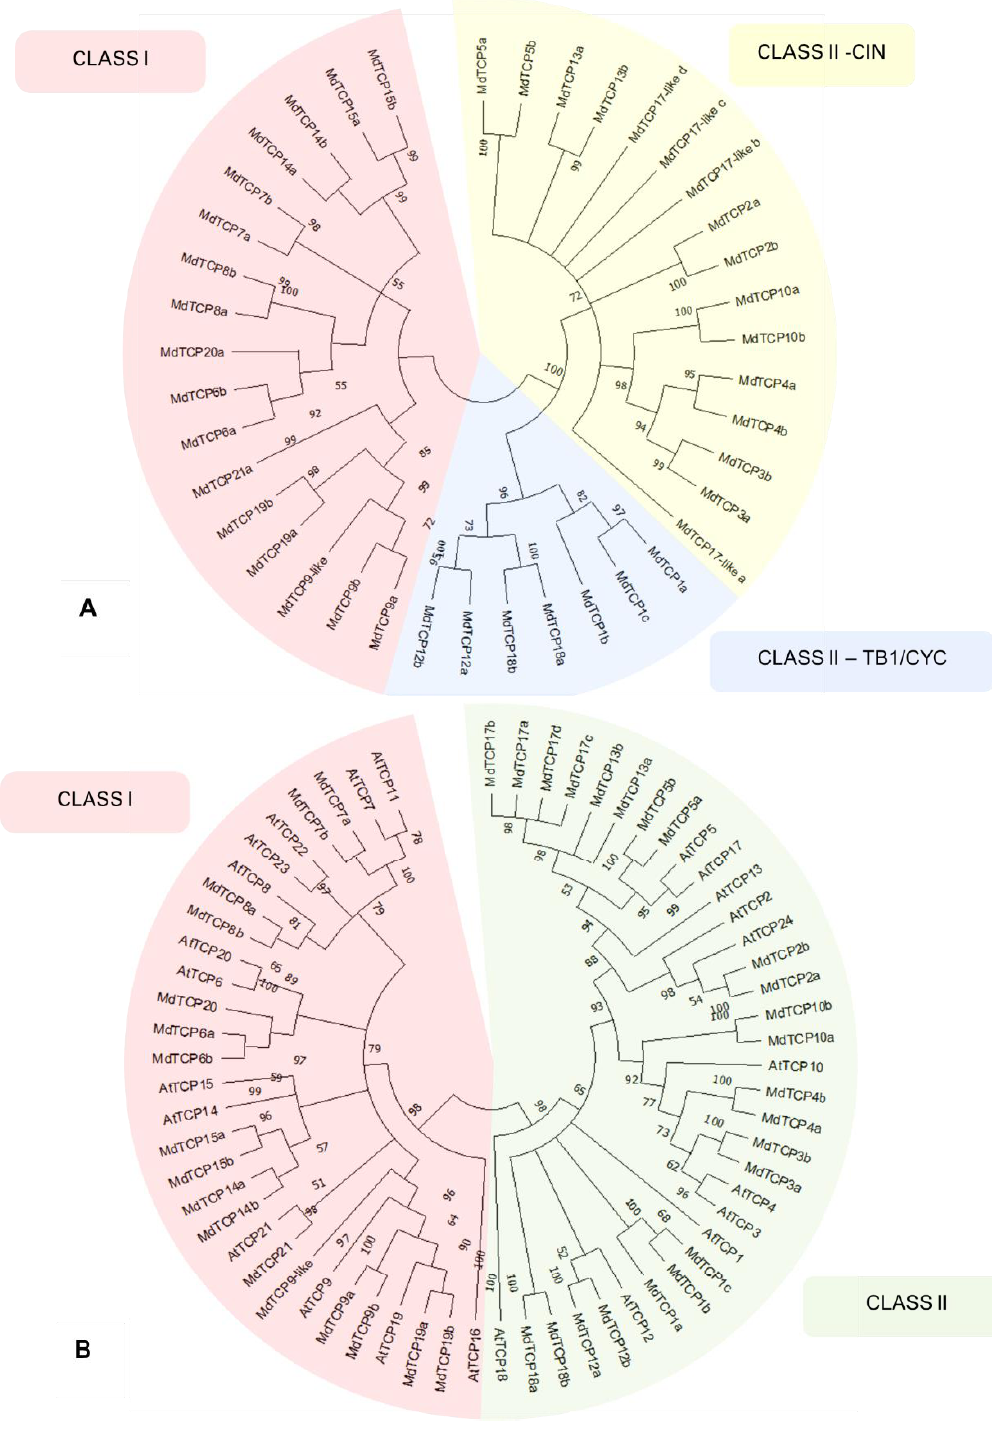
Figure 4. ( A ) Phylogenetic tree calculated on the 40 MdTCP genes classified in the present work. The different classes of TCPs are indicated with red (Class I), yellow (Class II-CIN) and blue (Class II–TB1/CYC). The tree was inferred using the neighbor-joining method [27] with 10,000 bootstrap re-iterations. Evolutionary distances were computed using the Poisson correction method [28] and are in the units of the number of amino acid substitutions per site. The rate variation among sites was modeled with a γ distribution. All positions with less than 60% site coverage were eliminated; i.e., fewer than 40% alignment gaps, missing data, and ambiguous bases were allowed at any position (partial deletion option). Node support is indicated as bootstrap values, and nodes with a support lower than 50 are collapsed. Analyses were conducted in MEGA X [22]. ( B ) Phylogenetic tree calculated from the amino acid sequences of the 40 MdTCP genes identified in the present work, and 24 AtTCPs . Members of the Class I are indicated with a red background, while those in Class II are indicated with a green background. Smart Model Selection algorithm [29] with Akaike Information Criterion (AIC) was applied to calculate the appropriate evolution model. The phylogenetic tree was inferred with the Jones – Taylor – Thornton substitution model, discrete γ distribution with three parameters, proportion of invariable site, and empirical amino acid frequencies count (JTT + G + I + F). Initial trees for the heuristic search were obtained by automatically applying the neighbor-join and BioNJ algorithms to a matrix of pairwise distances estimated using the JTT model and finally selecting the topology with the superior log-likelihood value ( − 37420,02). Nodes with a support lower than 50 are condensed. Analyses were conducted on PhyML 3.0 software [30] (Guindon; ac- cessed from Bolzano/Bozen, Italy).